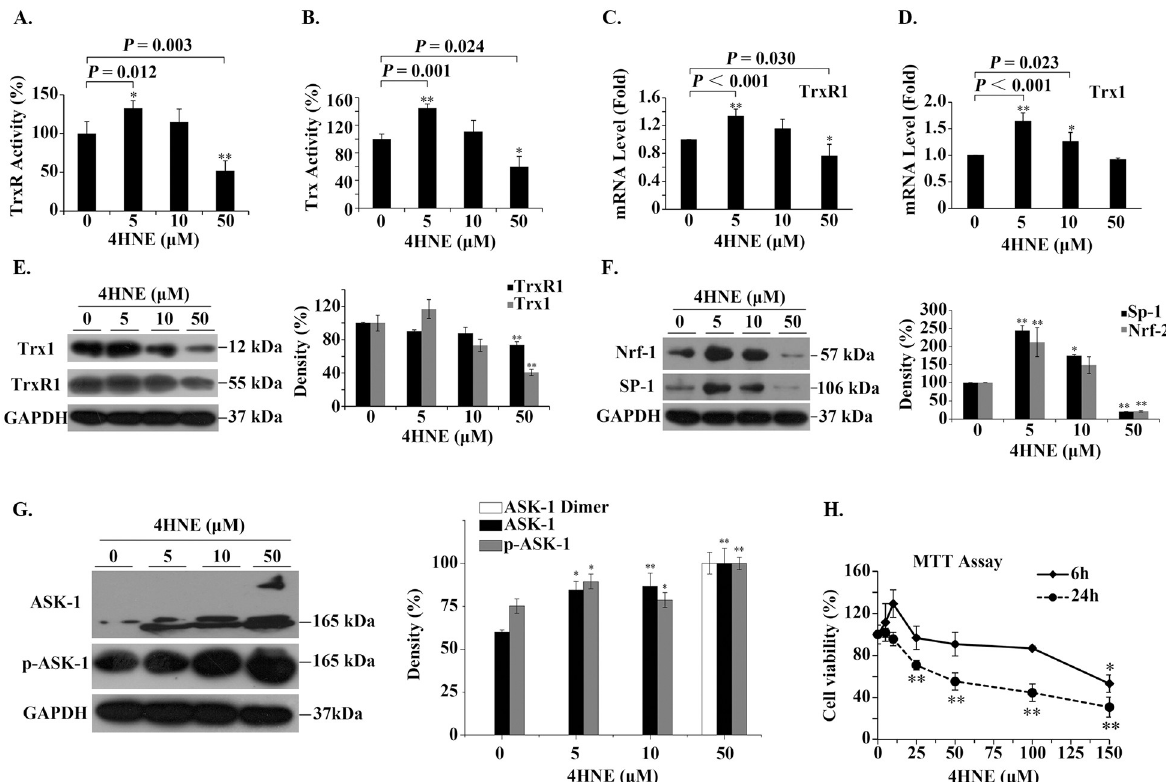
Fig 3. The effect of extracellular 4HNE on human bronchial epithelial cells. ( A,B ) The effect of extracellular 4HNE on the activities of cellular TrxR/Trx. The method used measures the total activity of TrxR/Trx. ( C,D ) The effect of extracellular 4-HNE on the transcription of TrxR1/Trx1. ( E,F,G ) Representative Western blots (left panel) and relative density values (right panel) for the bands in the left panel. GAPDH was used as an internal reference. In the bar graphs, the values are expressed as mean ± S.D. (n � 3). ( H ) Cell viability was affected by 4HNE concentration and incubation time. � , P < 0.05; �� , P < 0.01 versus control without 4HNE treatment.